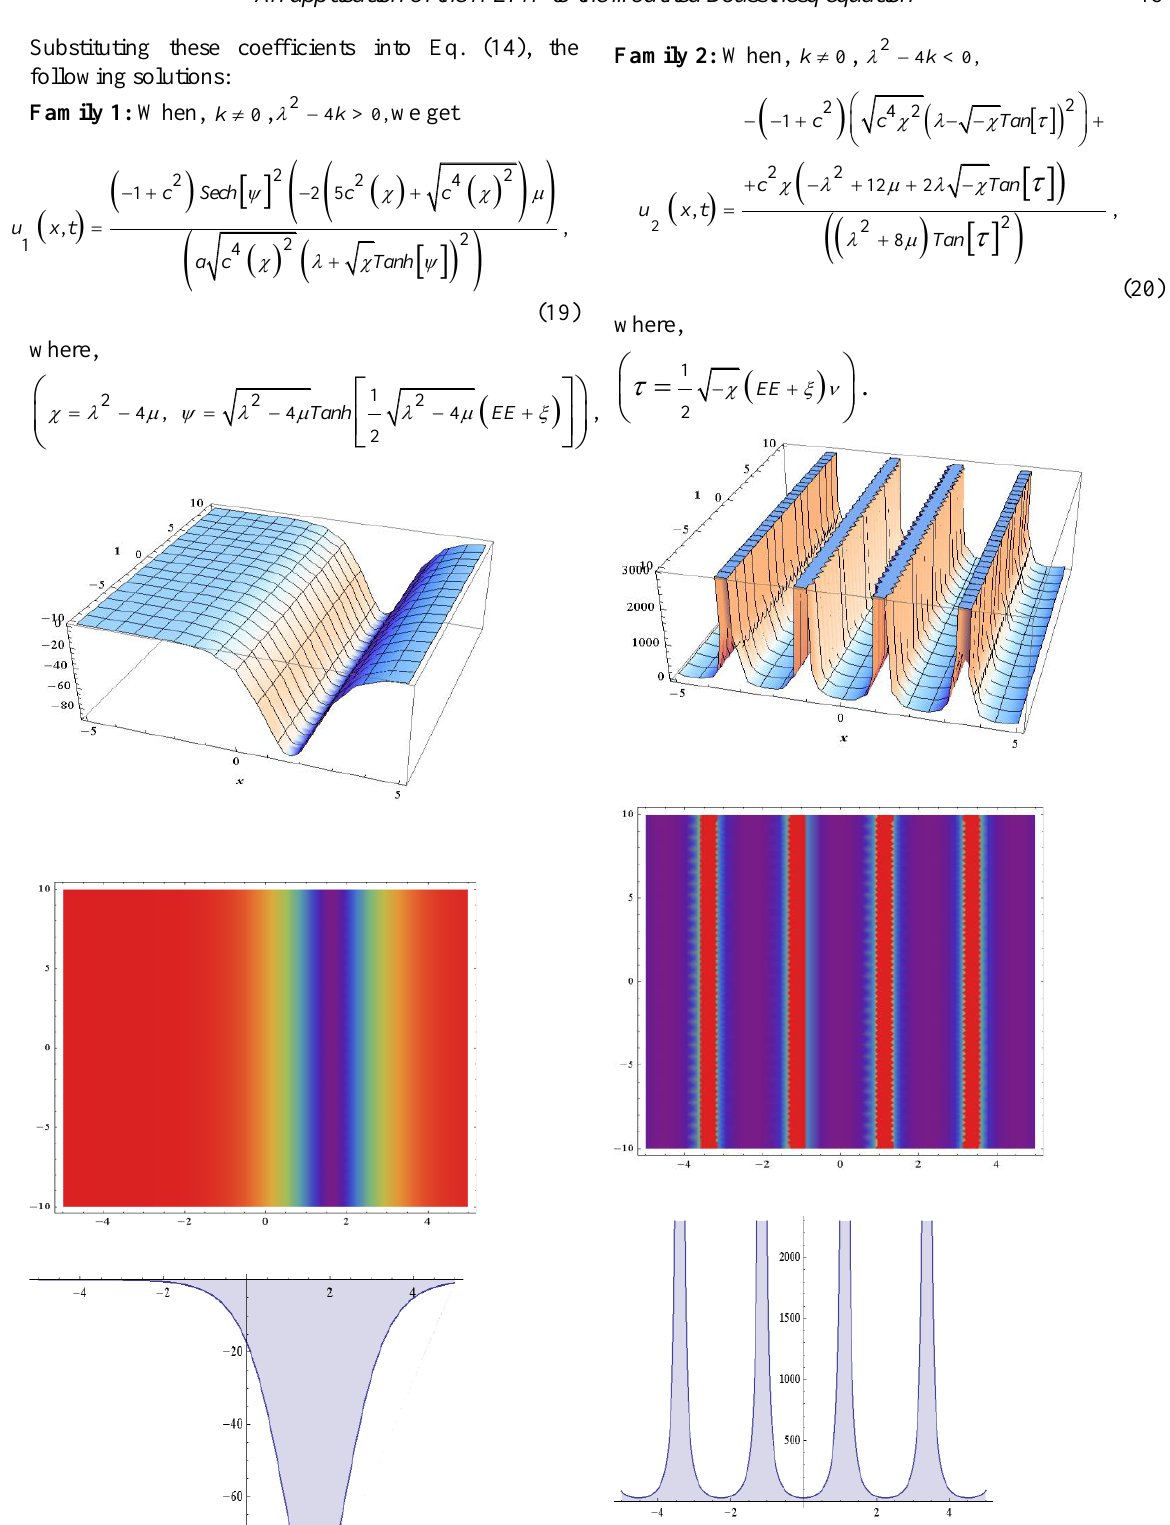
Figure-6. The 3D, density graphic and 2D surfaces of Eq. (20) in and 1 t =